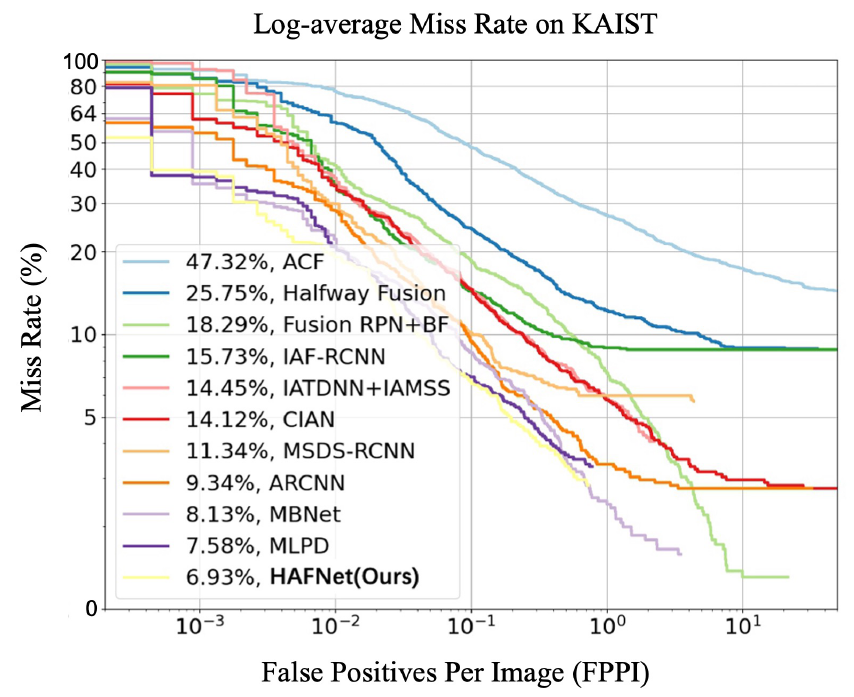
Figure 3. Comparison of the detection results with the state-of-the-art methods on the KAIST dataset under the sanitized